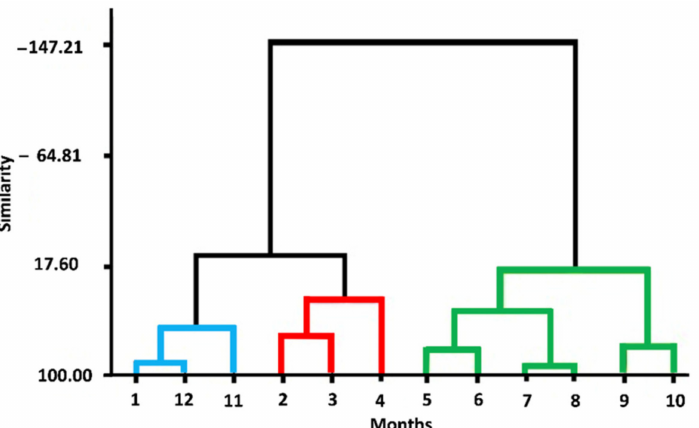
Figure 3. Cluster analysis for monthly precipitation and temperature in the period 1959–2010 recorded at meteorological stations near seven study sites. The months were grouped into three seasons of the year: blue lines correspond to the Nortes season, red lines refer to the dry season and green to the rainy